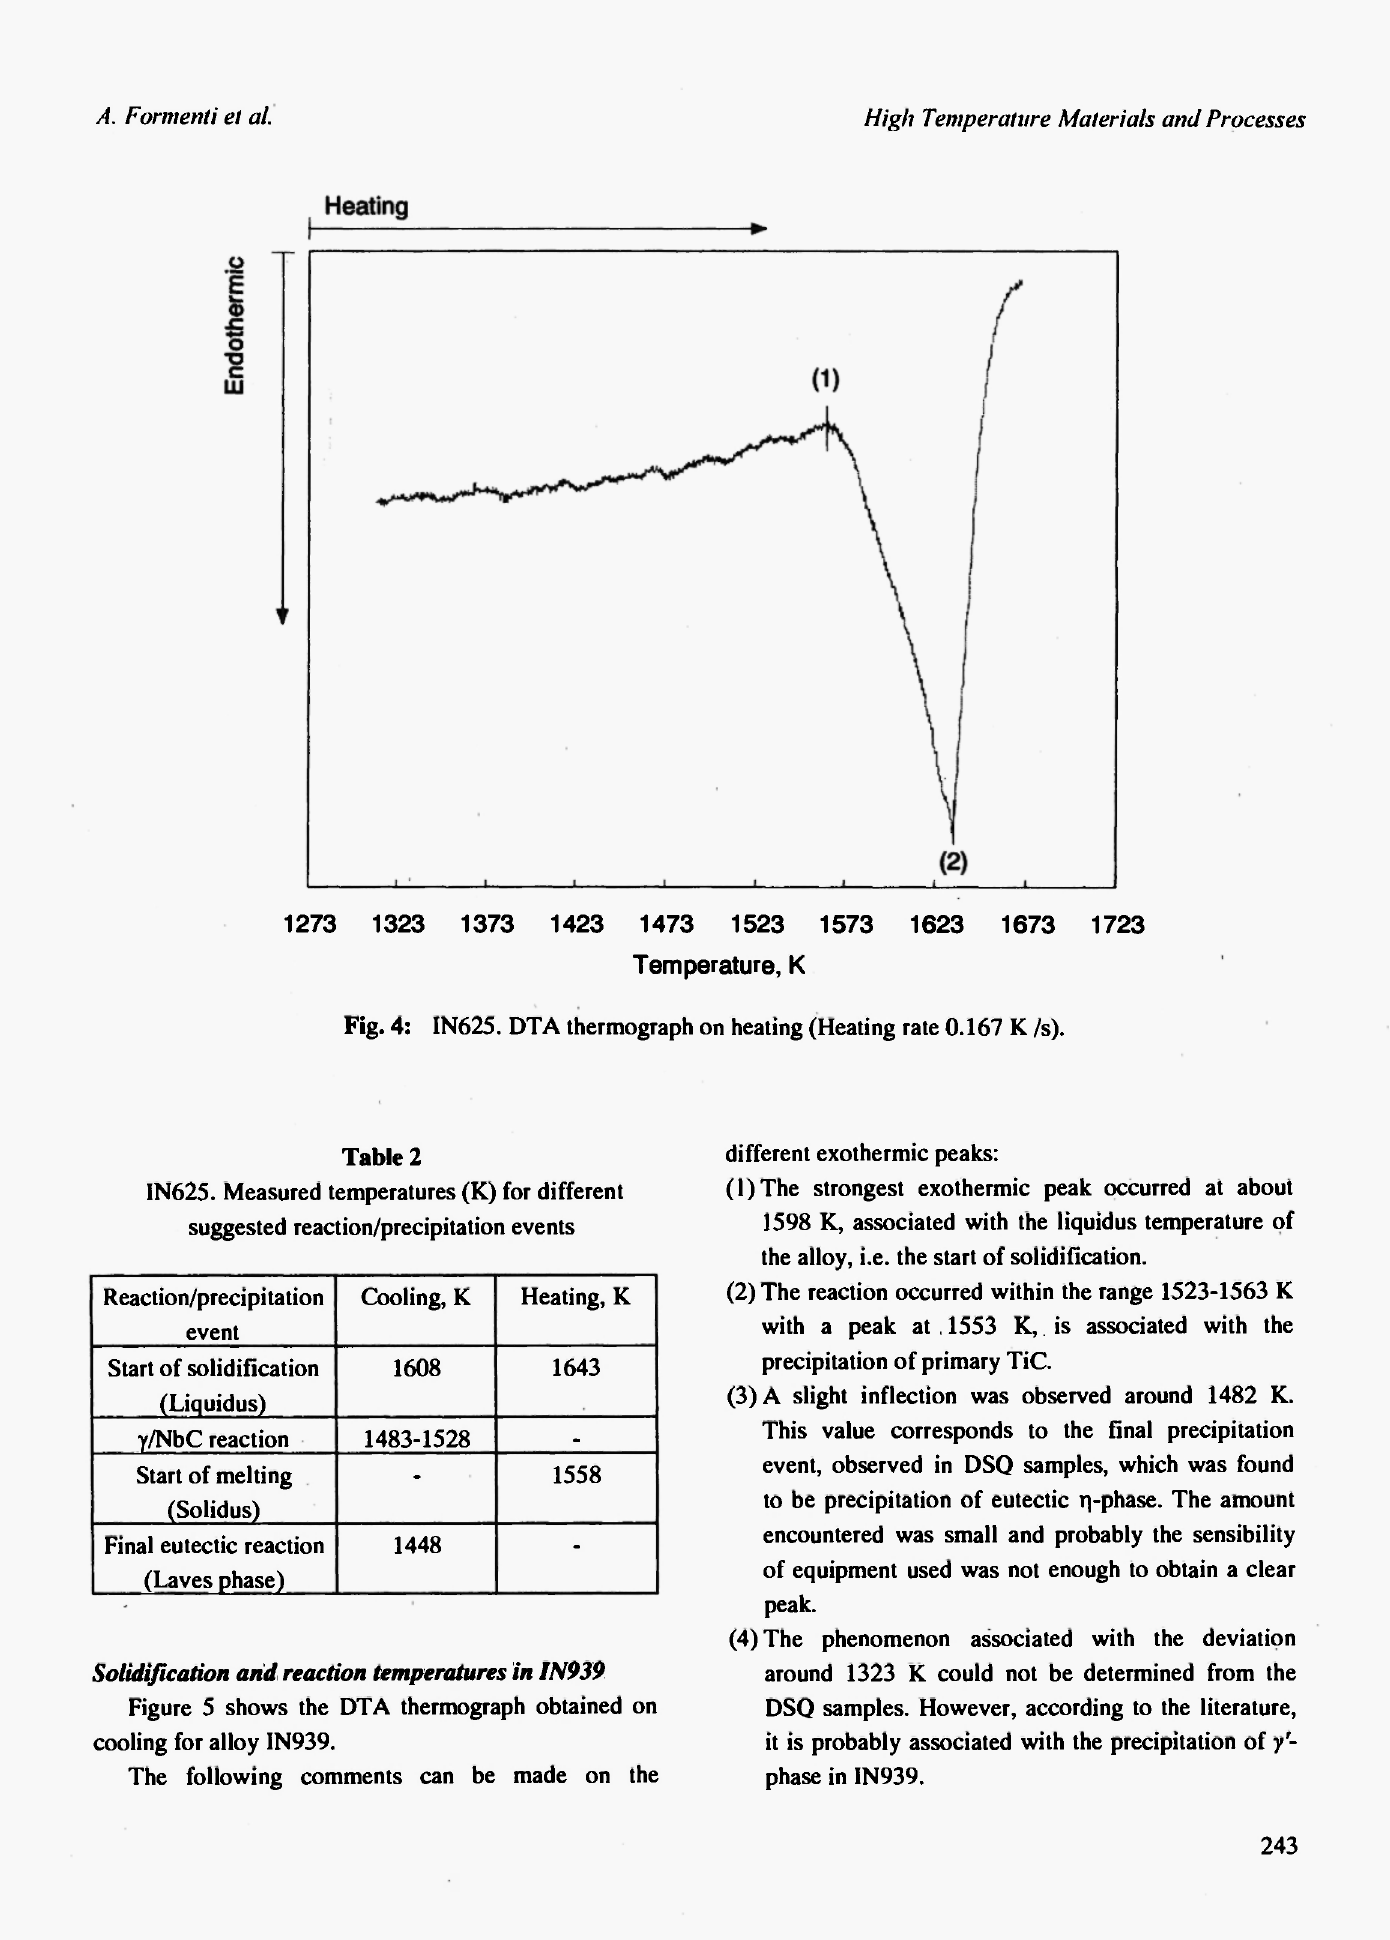
Fig. 4: ΙΝ625. DTA thermograph on heating (Heating rate 0.167 Κ /s).